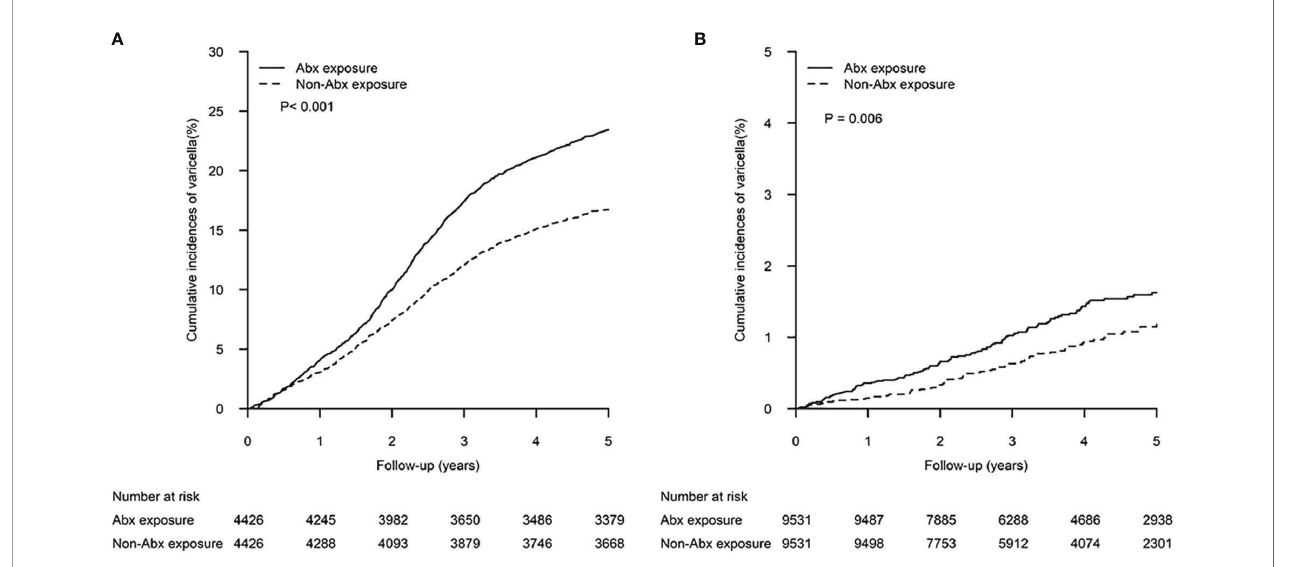
FIGURE 2 | Cumulative incidences of varicella in patients exposed to antibiotics within the fi rst 2 years of life and matched controls. The differences between the two study cohorts in the (A) pre-vaccination era and (B) vaccination era were determined by log-rank test.